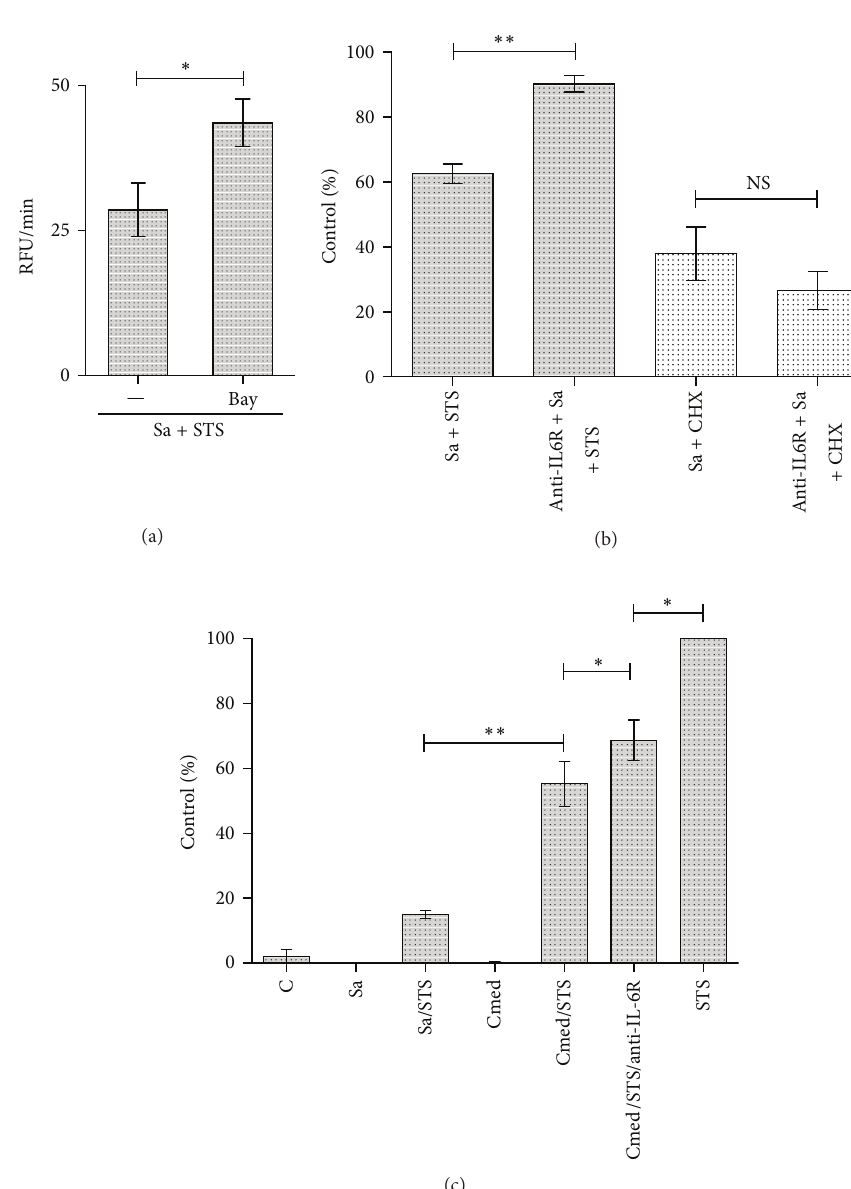
. ∗ 𝑃𝑃 𝑃 𝑃𝑃𝑃𝑃 ; SD; ∗∗ 𝑃𝑃 𝑃 𝑃𝑃𝑃𝑃 ± ±